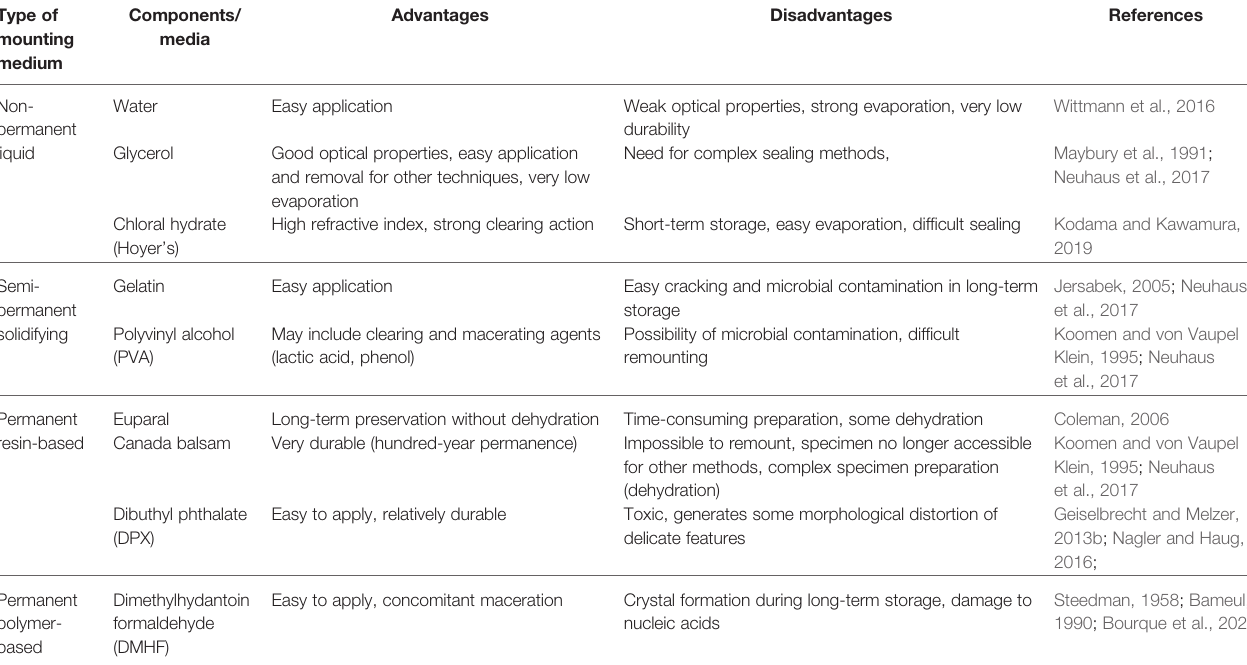
TABLE 4 | Advantages and disadvantages of mounting media commonly used for light-microscopy studies of